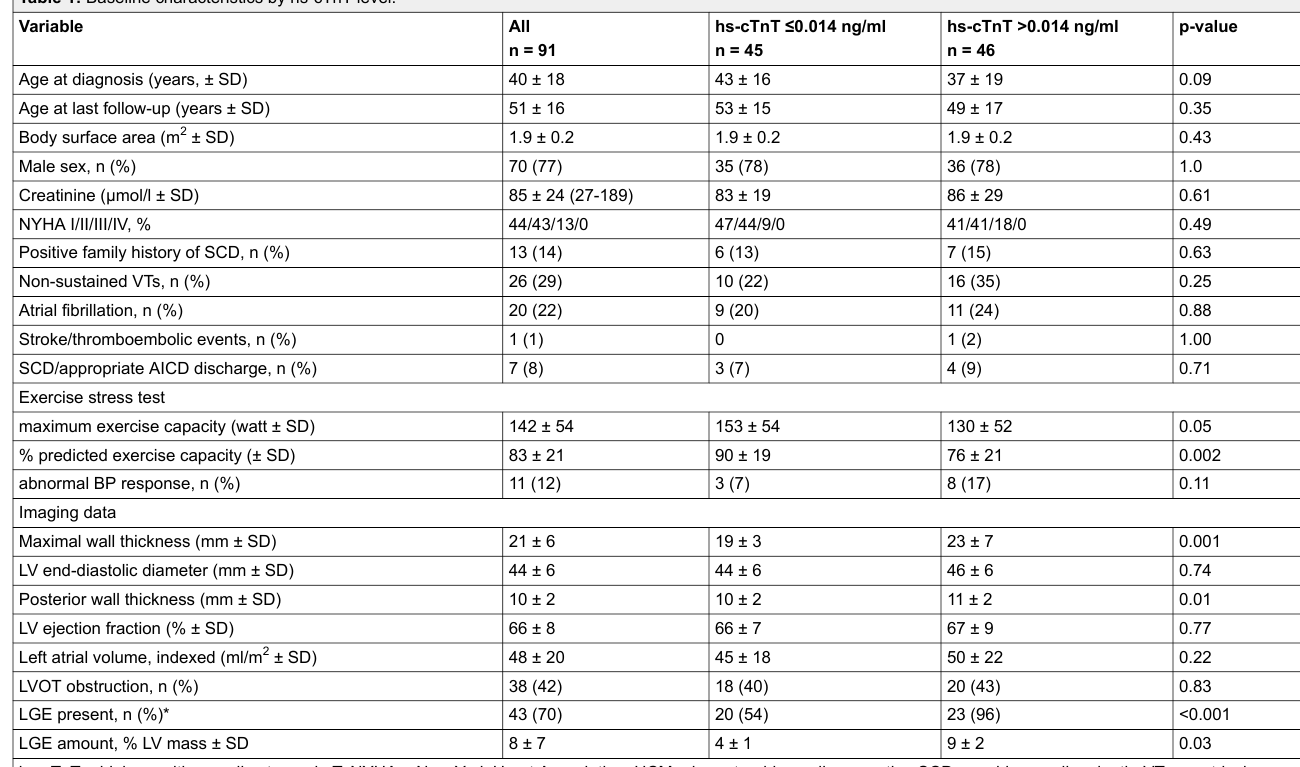
Table 1: Baseline characteristics by hs-cTnT level.